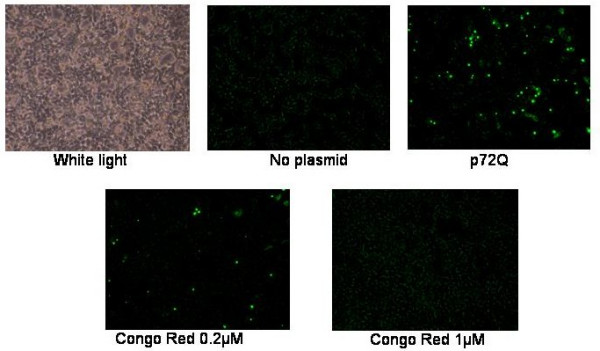
Inhibition of aggregation in HEK 293 cells transfected with plasmid, pcDNA3.1-72Httexon1-eGFP (p72Q). Series of control reactions including HEK293 photographed under white light or in dark field, aggregate formation produced by p72Q and inhibition of aggregation by Congo red (0.2 μM or 1 μM) added concurrently with p72Q.